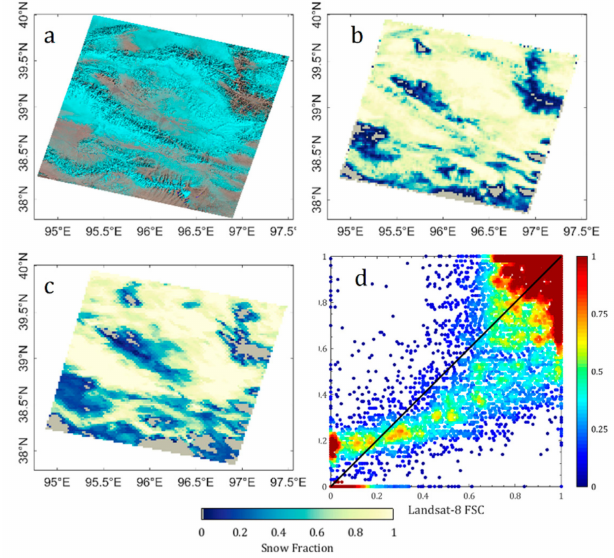
Figure 9. A case evaluation of Himawari–8 AHI fractional snow cover with Landsat–8 data for a very rugged area: ( a ) Landsat–8 OLI image at WRS-2 136 / 033 on 8 January 2016; ( b ) the corresponding Landsat–8 fractional snow cover; ( c ) the corresponding Himawari–8 AHI fractional snow cover at UTC 4:10 a.m.; ( d ) the scatter plot displaying 9435 points of Himawari–8 AHI fractional snow cover versus Landsat–8 fractional snow cover at a 0.02 ◦